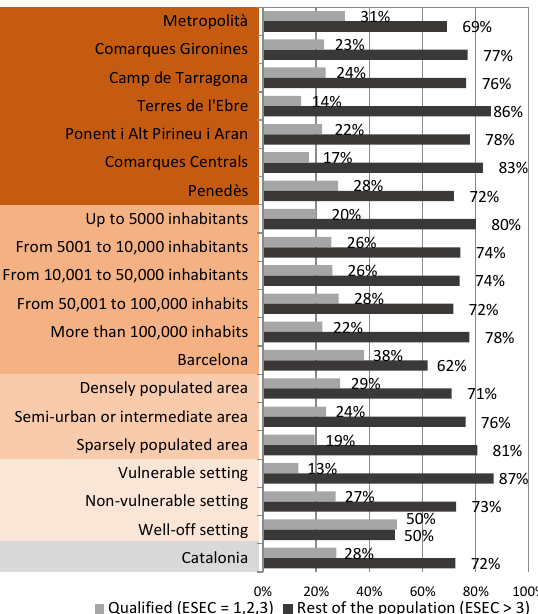
Figure 3. ESEC (9 + 1) social structure. Working people aged from 16 to 64 years, Catalonia. Source: In-house construction based on the ECVHP, 2011.